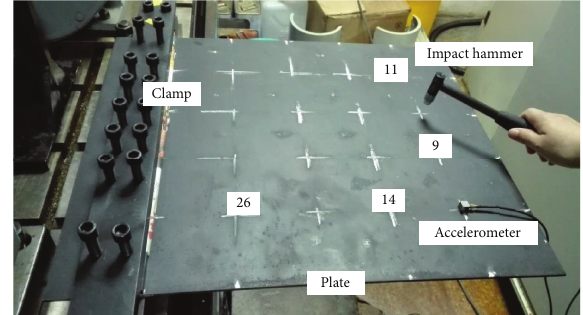
Figure 20: The Mindlin plate structure applied for load